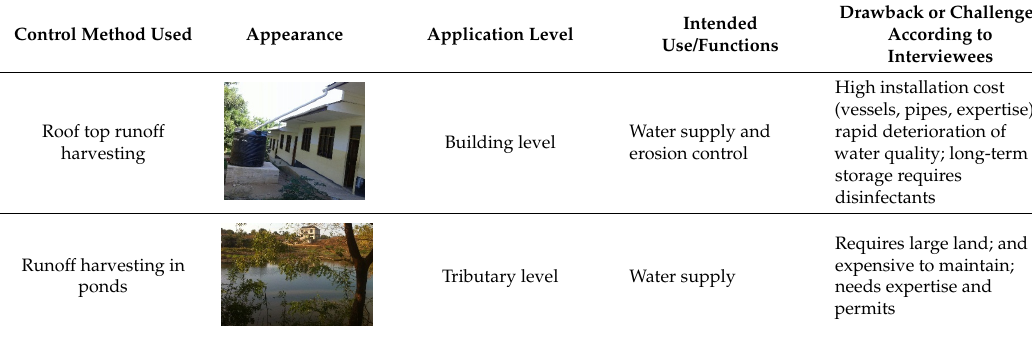
hydraulic capacity standards when considering attached catchment area. The drain layouts in these two roads were similar to the rest, except that the roads ran almost along the mountain ridges, such that the drains had relatively smaller catchment from which the runoff could be collected. Based on the condition of repair, operation, and hydraulic capacity, all drains along the remaining roads could hardly meet their intended design goals. Table 3. Extent and conditions of public stormwater infrastructures along the four main roads along and across the Mbezi River. The location of drainage channels (D1 to D8) is shown in Figure 1. All the channels were trapezoidal in shape, concrete lined, non-traversable, and not covered. S = channel slope (%); L = channel length (m). All roads had drainage channels on both sides of the road, and they were all investigated.